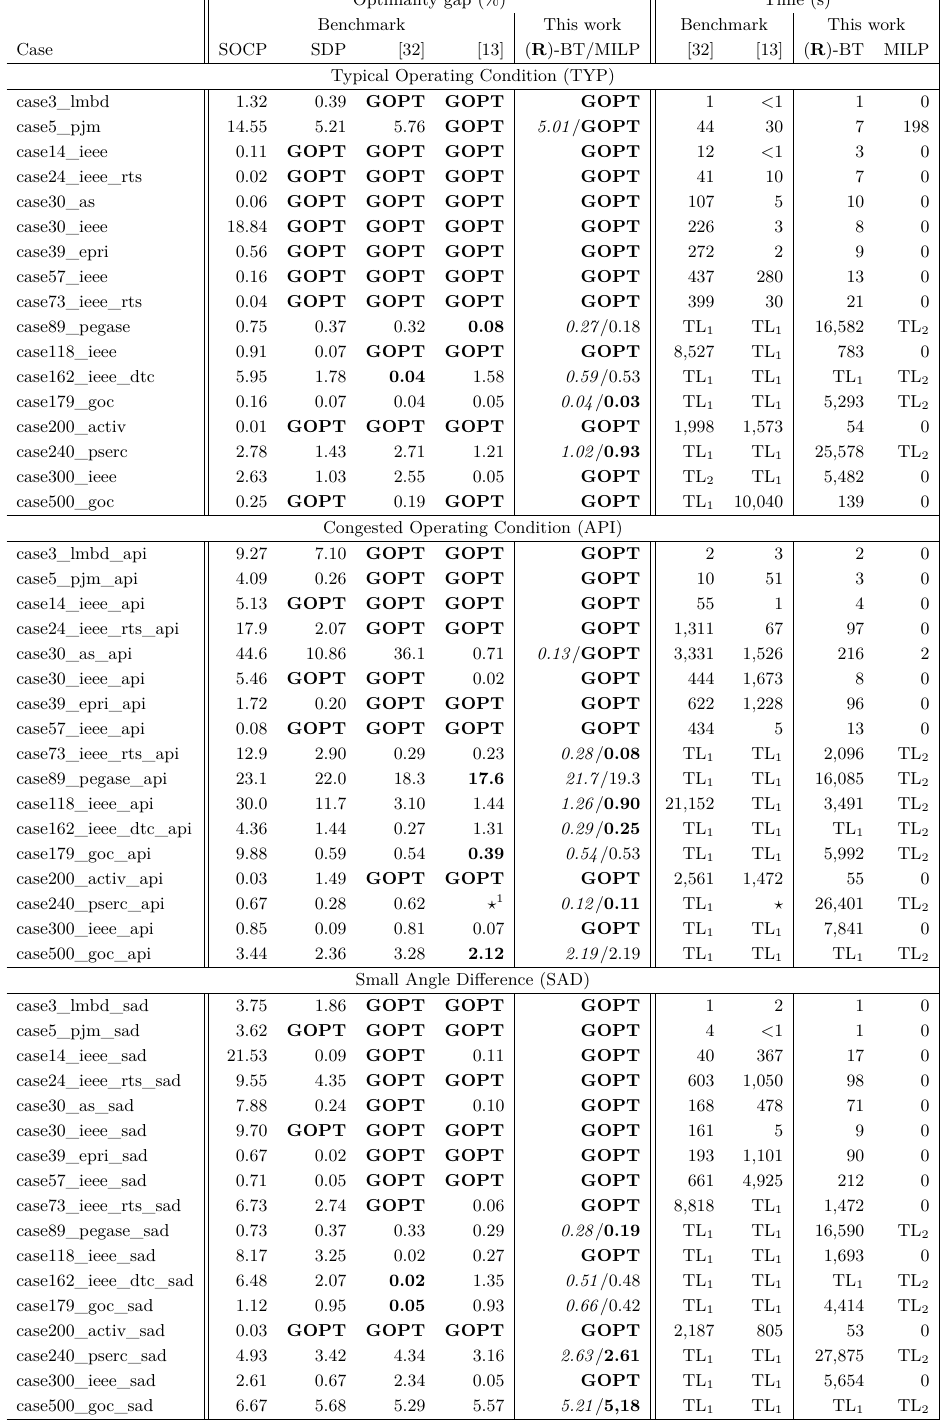
Table 2 Results for the instances from IEEE PES PGLib AC-OPF v21.07 with less than 500